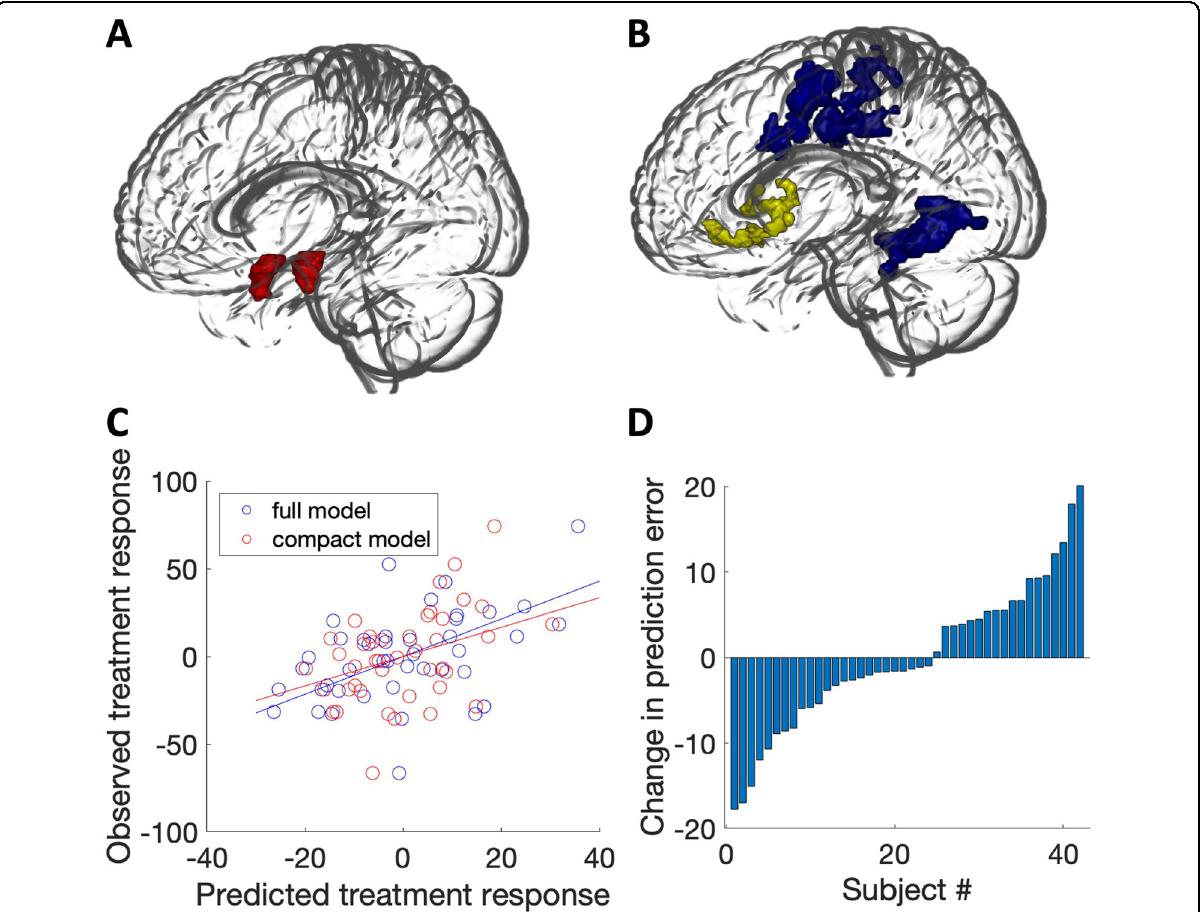
Fig. 1 The predictive model and independent replication results. A The seed region for the connectivity-based predictive model: bilateral, anatomically de fi ned amygdala (red). B Treatment response was predicted by a linear combination of greater amygdala connectivity with a subgenual cingulate/caudate/putamen cluster (yellow) and reduced amygdala connectivity with bilateral central sulcus clusters and right temporal- occipital clusters (blue). C Predicted treatment response for the compact model (including only baseline symptom severity, red points) vs. the full model (also including amygdala connectivity, blue points). Successful replication would be indicated by an improved prediction for the full model vs. the compact model. D Changes in prediction errors for the full vs. compact model for each subject. The inclusion of amygdala connectivity slightly improved model predictions (increase of 2% variance explained), with marginal statistical signi fi cance. Brain images were created using